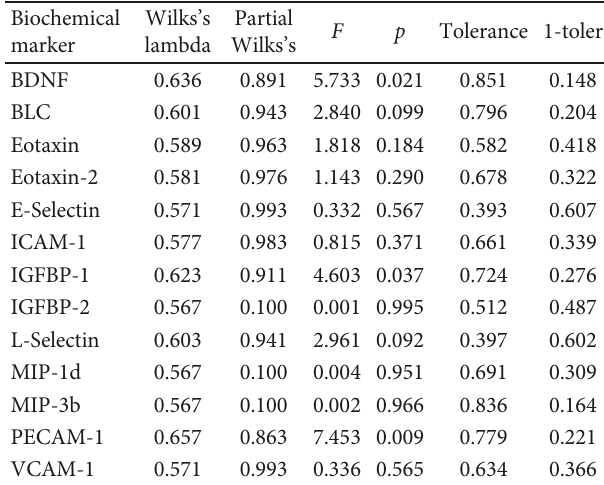
Table 3: Predictive values of selected markers marked with discriminant analysis by standard method.